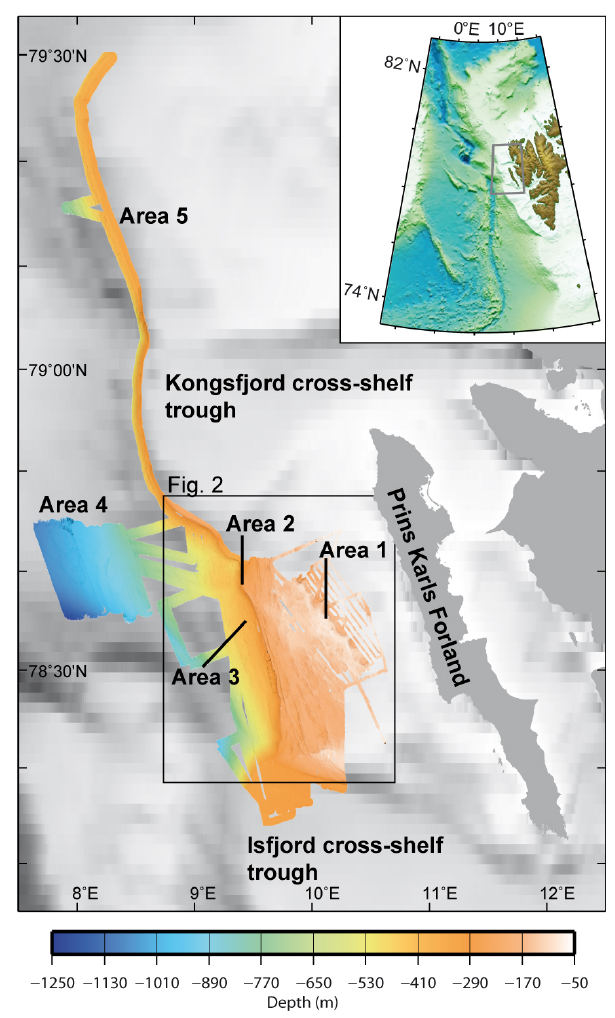
Figure 1. Multibeam bathymetry obtained during R/V Heincke cruise He-387 (color) plotted on IBACO bathymetry (Jakobsson et al., 2008) showing the study areas (Areas 1 to 5) at the continen- tal margin west of Svalbard. Inset shows an overview map with the location of the main